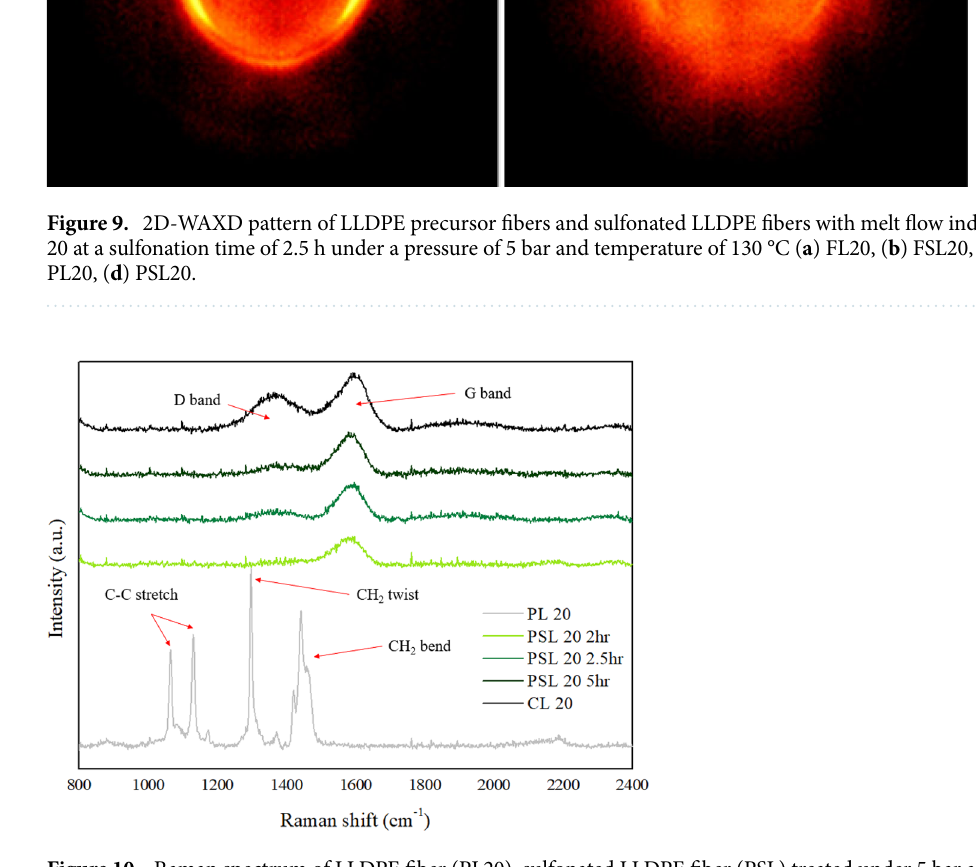
Figure 10. Raman spectrum of LLDPE fiber (PL20), sulfonated LLDPE fiber (PSL) treated under 5 bar and various time conditions, and polyethylene based carbon fiber prepared by LLDPE